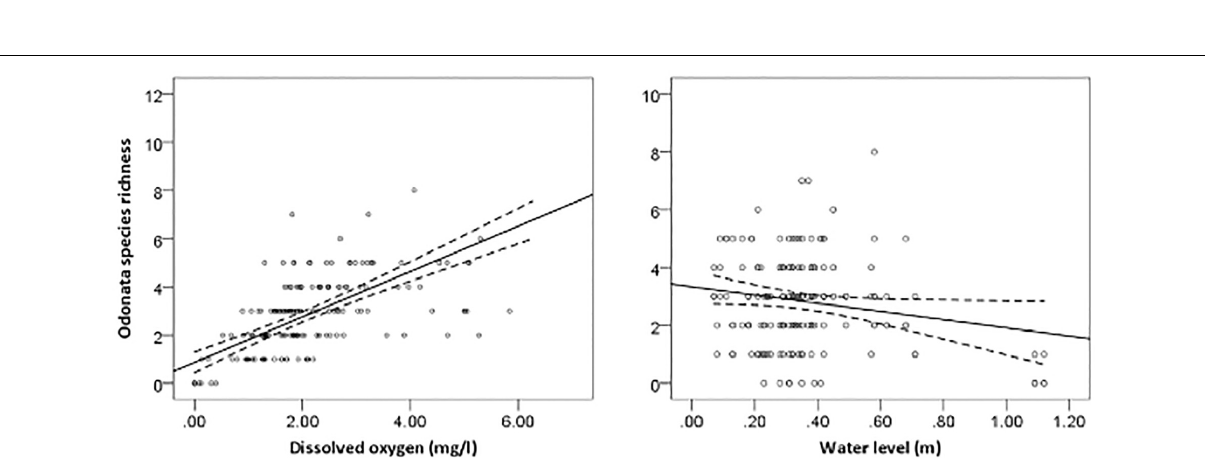
FIGURE 6 | Responses of Odonata species richness to dissolved oxygen (mg/l) and water level (m). Based on GLMs, scatter plots have 95% confidence intervals (dashed) on the regression (solid) line.